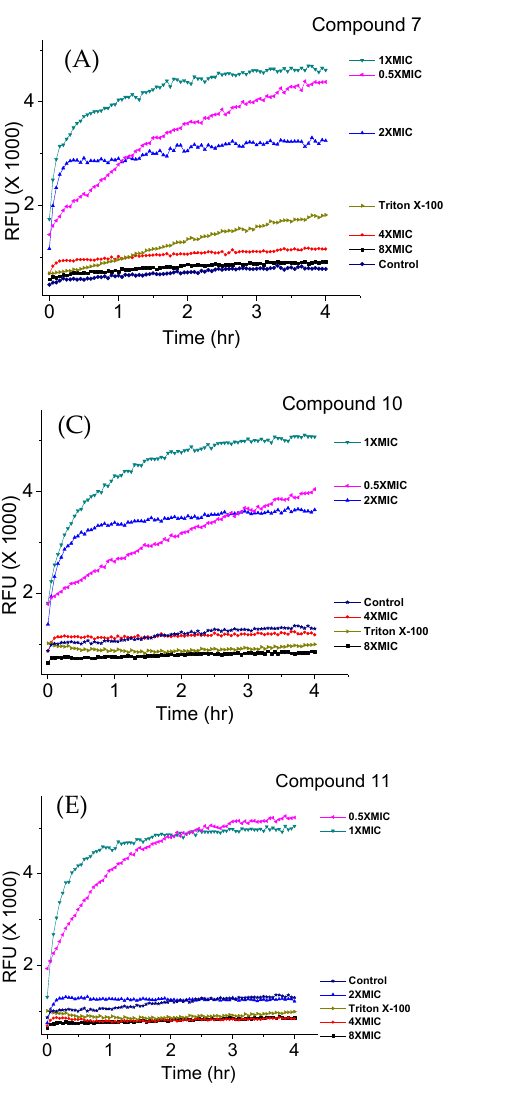
Figure 7. Kinetic membrane permeabilization of C. neoformans H99 using varied concentrations of AKs. ( A ) Cells treated with compound 7 using SYTOX TM green; ( B ) cells treated with compound 7 using PI; ( C cells treated with compound 10 using SYTOX TM green; ( D ): cells treated with compound 10 using PI; ( E cells treated with compound 11 using SYTOX TM green; ( F ): cells treated with compound 11 using PI. The figure with standard deviation is available in Supplementary Materials.